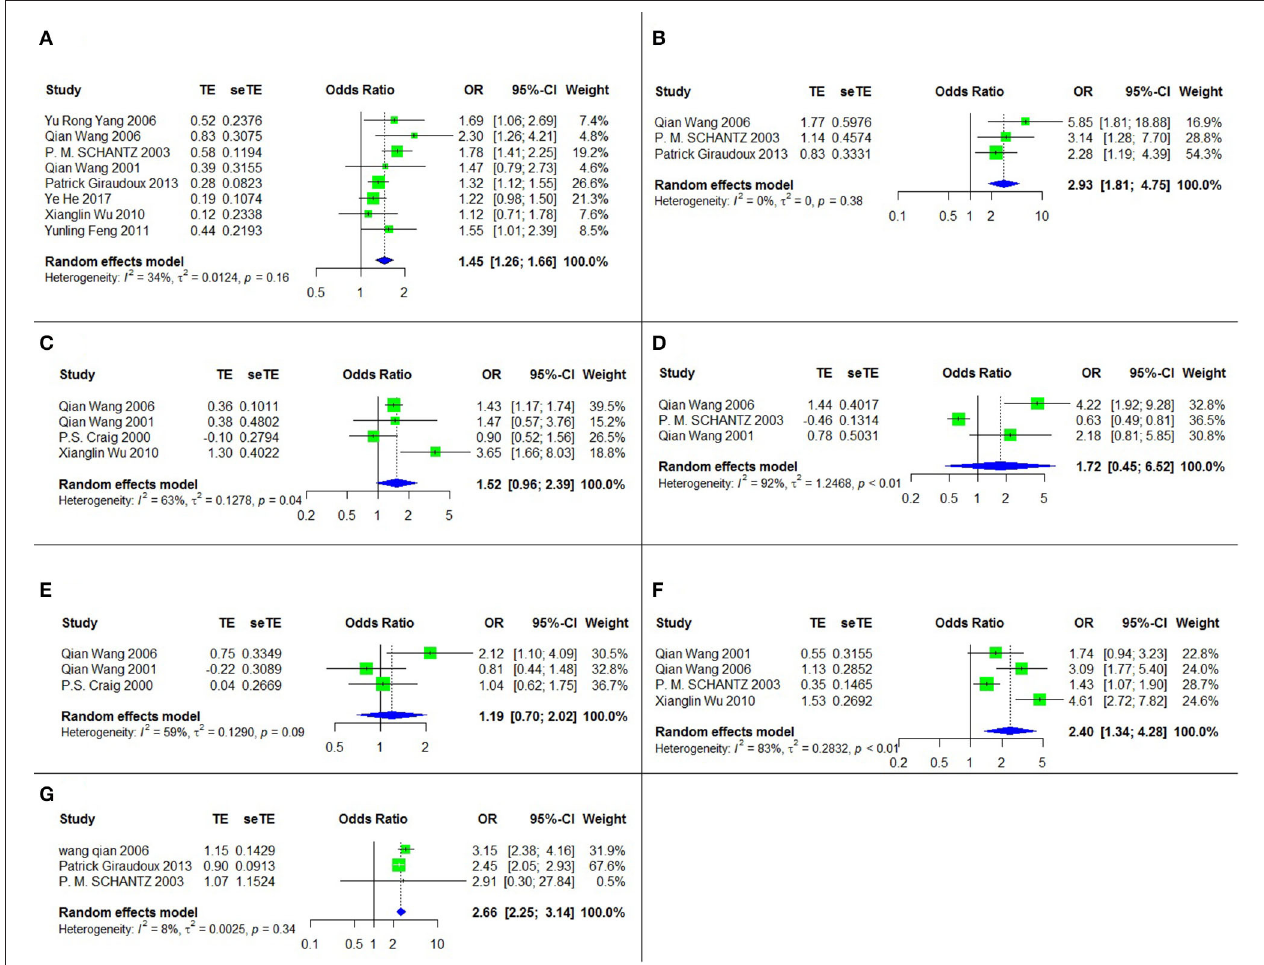
FIGURE 3 | The forest chart of AE factors. (A) Sex (female/male); (B) Ethnicity (Tibetan/Han); (C) Dog ownership; (D) Playing with dogs; (E) Contanct with fox hides; (F) Not washing hands before meals; (G) Herdsman